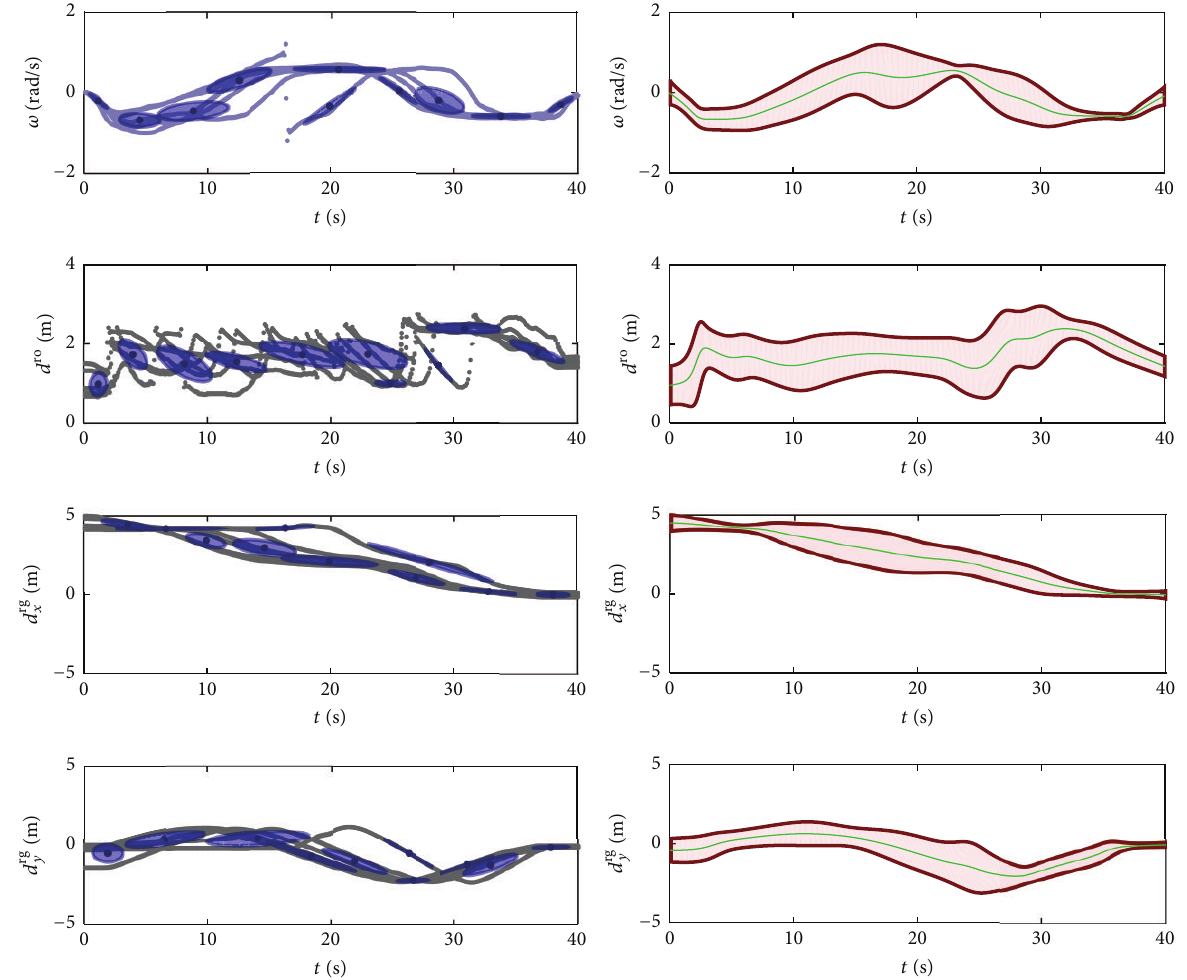
Figure 10: Encoding and retrieval for orientation and distance information in task 2.